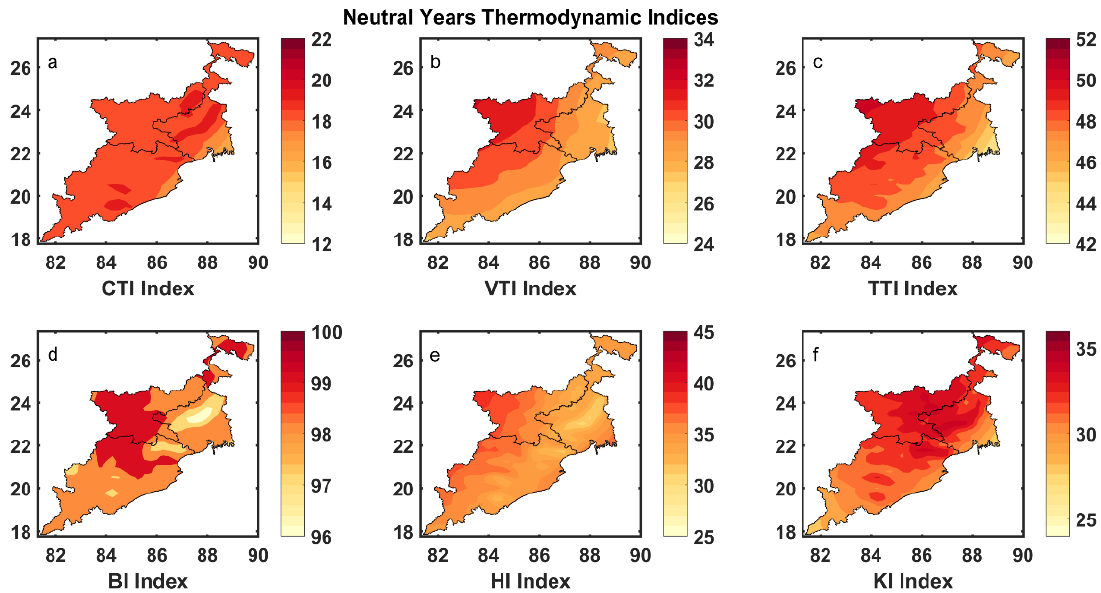
Figure 7. CTI ( a ), VTI ( b ), TTI ( c ), BI ( d ), HI ( e ), KI ( f ) variations during La-Niña years from 1998 to 2014.